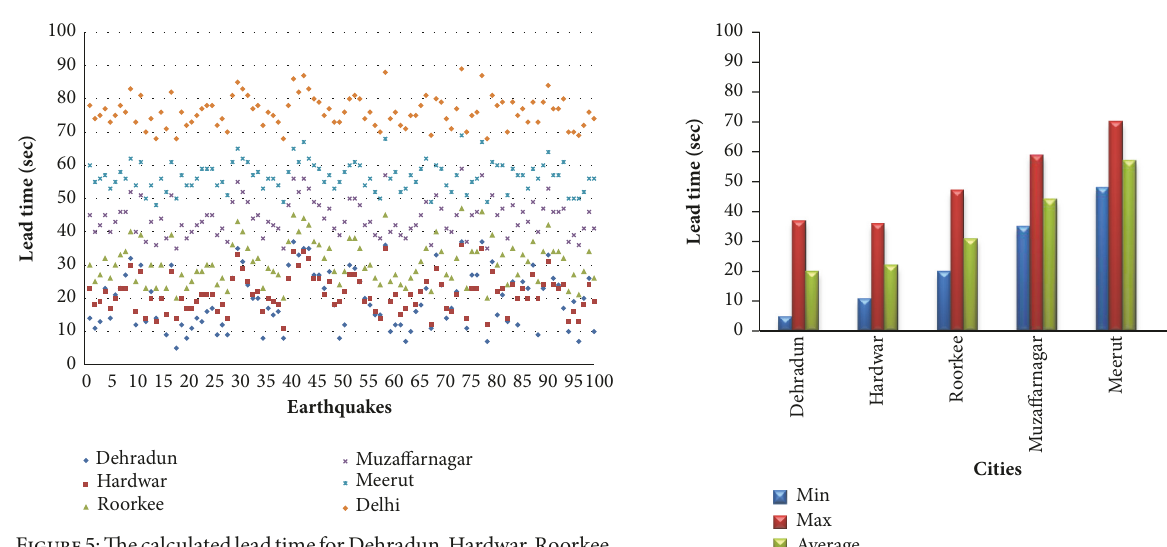
Figure5:ThecalculatedleadtimeforDehradun,Hardwar,Roorkee, Muzaffarnagar, Meerut, and Delhi for the earthquakes (EQ) origi- nated in the selected EEW seismic network region. Figure6:Themaximum,minimum,andaverageleadtimeachieved using the proposed EEW algorithm for Dehradun, Roorkee, Hard- war, Muzaffarnagar, Meerut, and